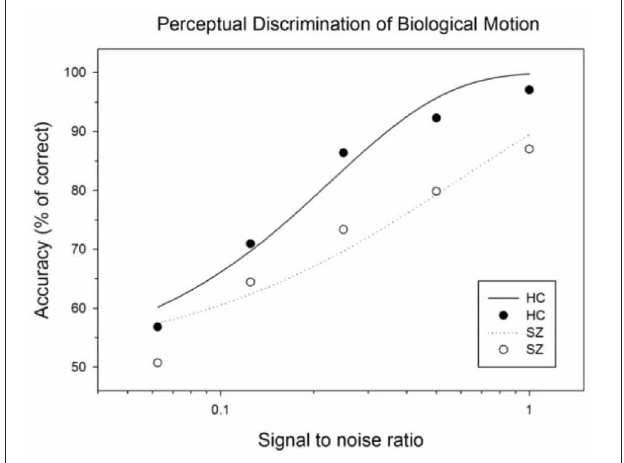
FIGURE 2 | Subject performances as a function of signal to noise ratio of BM stimulus. The curves represent the fits of data by a psychometric function (Weibull equation) for each subject